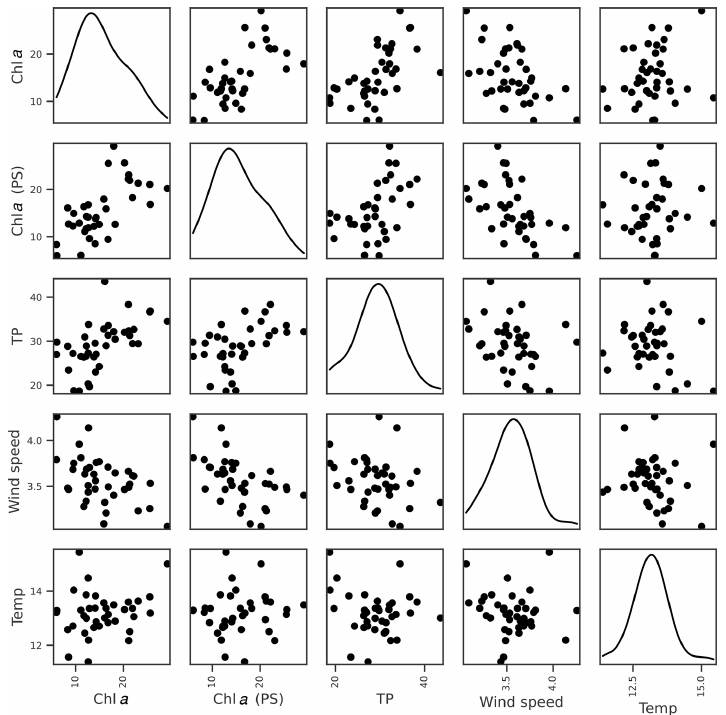
Figure 4. Relationships between seasonal mean chl a (mgL − 1 ) and potential explanatory variables of interest, including chl a from the previous summer (PS), seasonal mean TP (µgL − 1 ), wind speed (ms − 1 ), and air temperature ( ◦ C). Density plots estimated using kde are shown along the diagonal.